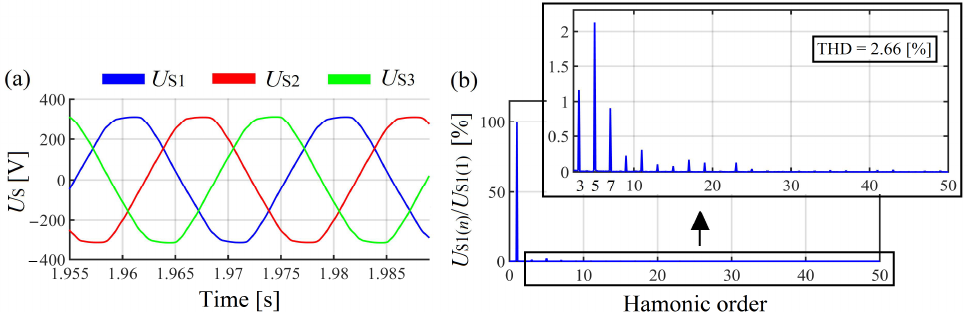
Figure 3. PCC voltage waveforms ( a ) and its spectrum (p.u.) ( b ) when the considered load is not connected (measured).